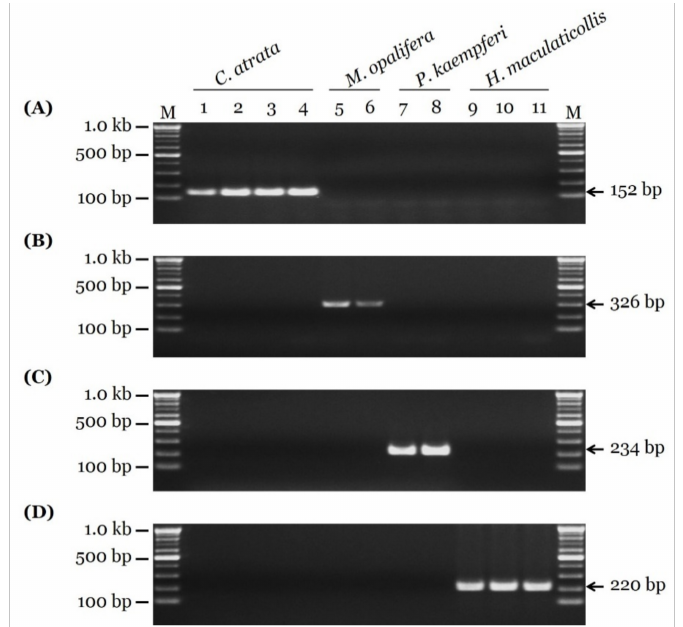
Figure 2. Gel images showing species-specific SCAR PCR results. Fragments of COI regions of ( A ) C. atrata , ( B ) M. opalifera , ( C ) P. kaempferi , and ( D ) H. maculaticollis were produced using CA_F1 / CA_R1-1, MO_F1-1 / MO_R2, PK_F1-1 / PK_R1, and HM_F1-1 / HM_R1 primer pairs, respectively. Primer sequences listed in Table 2. Lanes 1 to 4 correspond to Samples CA-1 to CA-4, respectively, of C. atrata ; Lanes 5 and 6 correspond to Samples MO-1 and MO-2, respectively, of M. opalifera ; Lanes 7 and 8 correspond to Samples PK-1 and PK-2, respectively, of P. kaempferi ; Lanes 9 to 11 correspond to Samples HM-1 to HM-3, respectively, of H. maculaticollis . Information of 11 samples provided in Table 1. Lane M represents 100 bp DNA ladder. Arrows indicate precise sizes of PCR